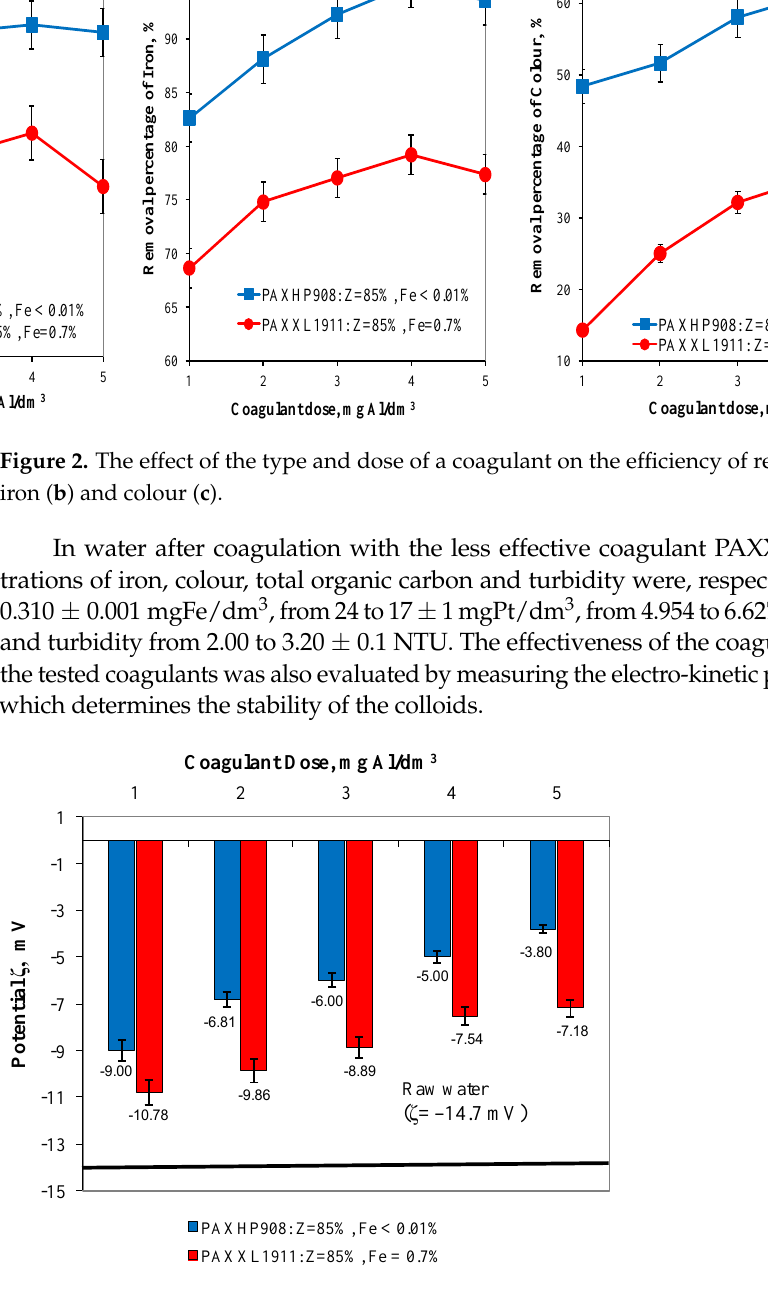
Figure 3. The effect of the type and dose of a coagulant on the change in zeta potential.